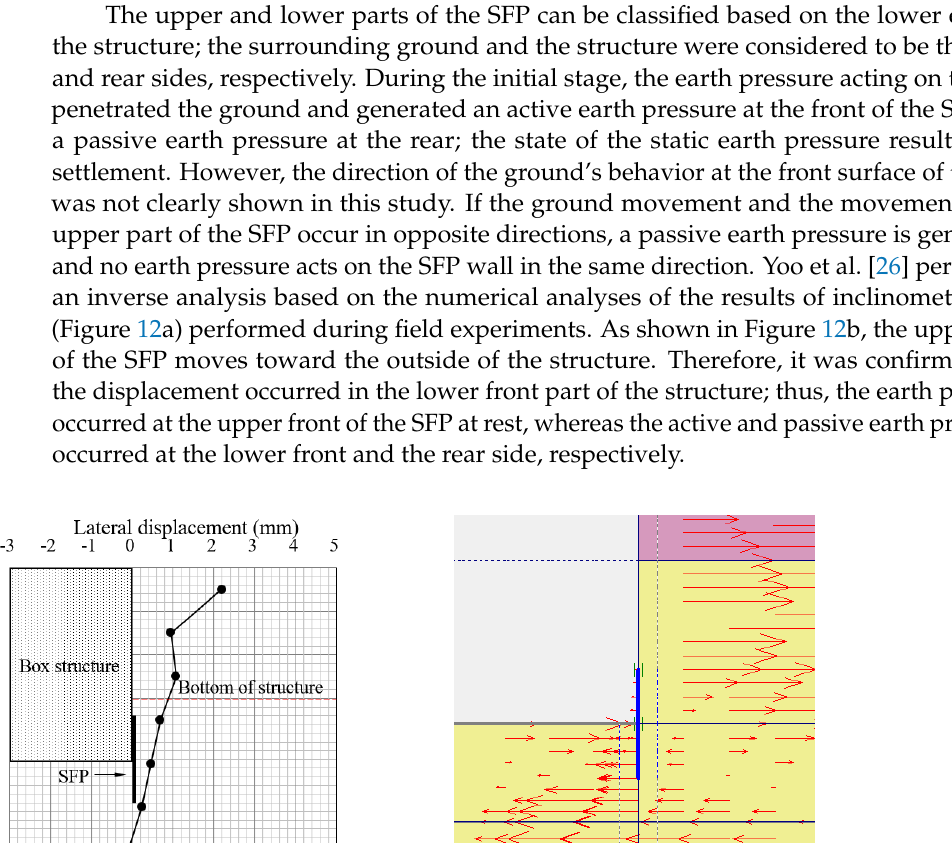
Figure 12. Displacement behavior of the ground: ( a ) inclinometer results; ( b ) finite element method results